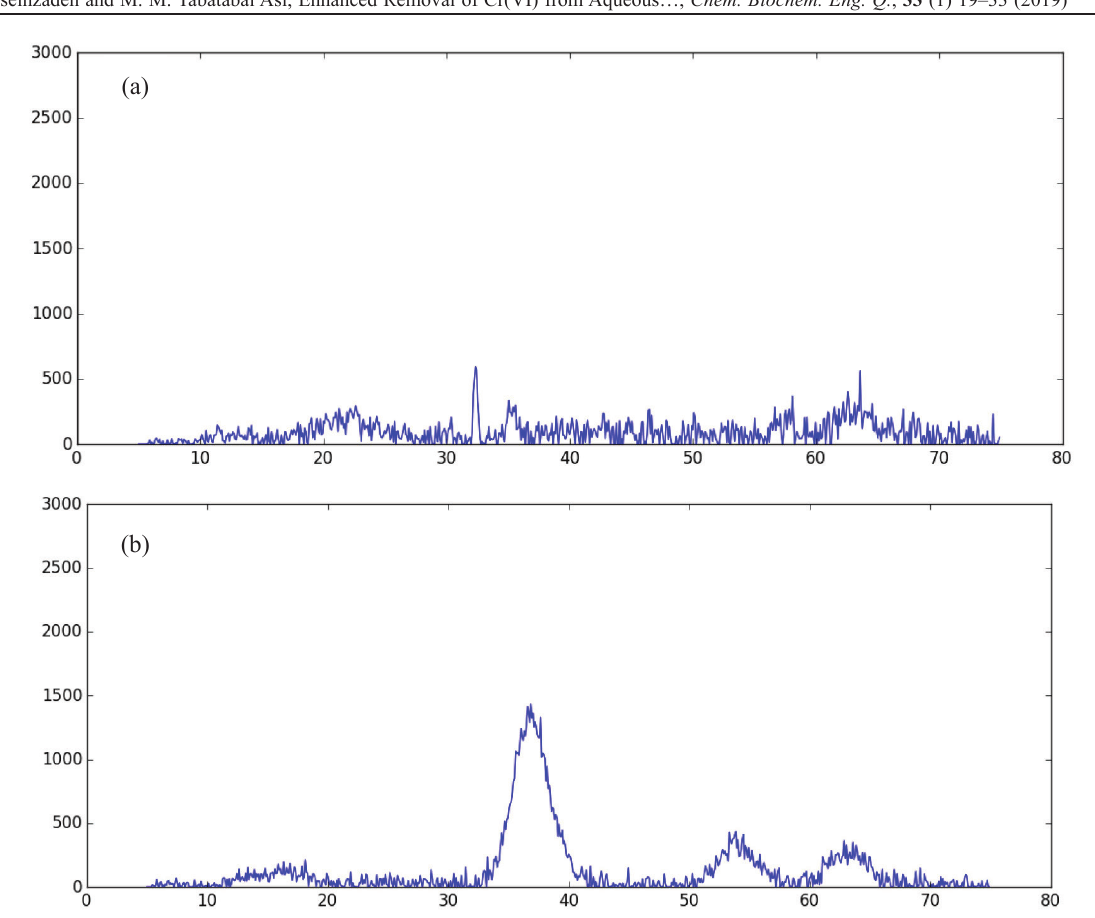
Fig. 5 – XRD pattern of poly(AA-co-AM)/Fe